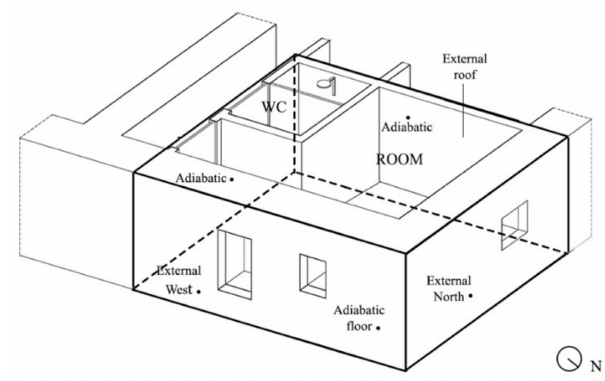
Figure 4. Axonometric view of the room.